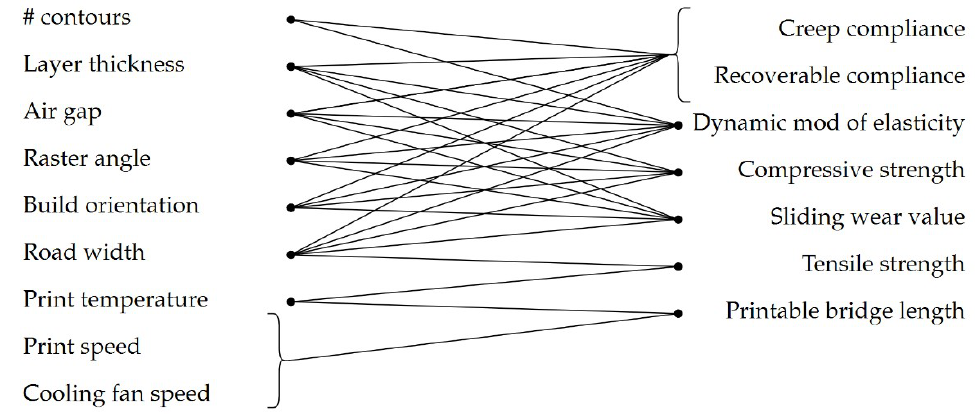
Figure 3. Matching diagram relating material extrusion process parameters to quality indicators from successful implementations. Adapted from Wang et al. [8].